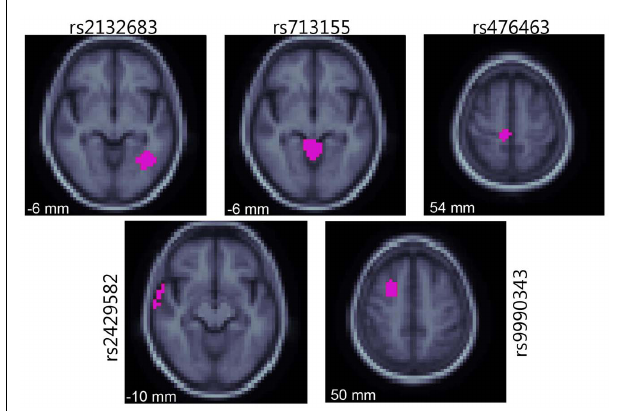
FIGURE 3 |The five most highly associated SNPs identified by vGWAS are shown on slices of an averaged brain MRI template, indicating regions where these SNPs were the most highly associated out of all SNPs ( in purple ). Coordinates refer to the ICBM standard space, and the cohort is the ADNI sample. Adapted from Stein et al.